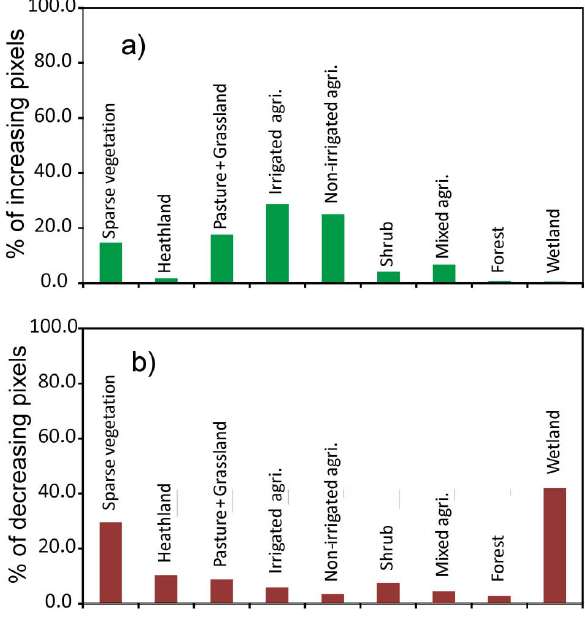
Fig. 9. The distribution of areas with (a) increasing trend, (b) de- creasing trend in yearly average NDVI for different land covers in the Konya